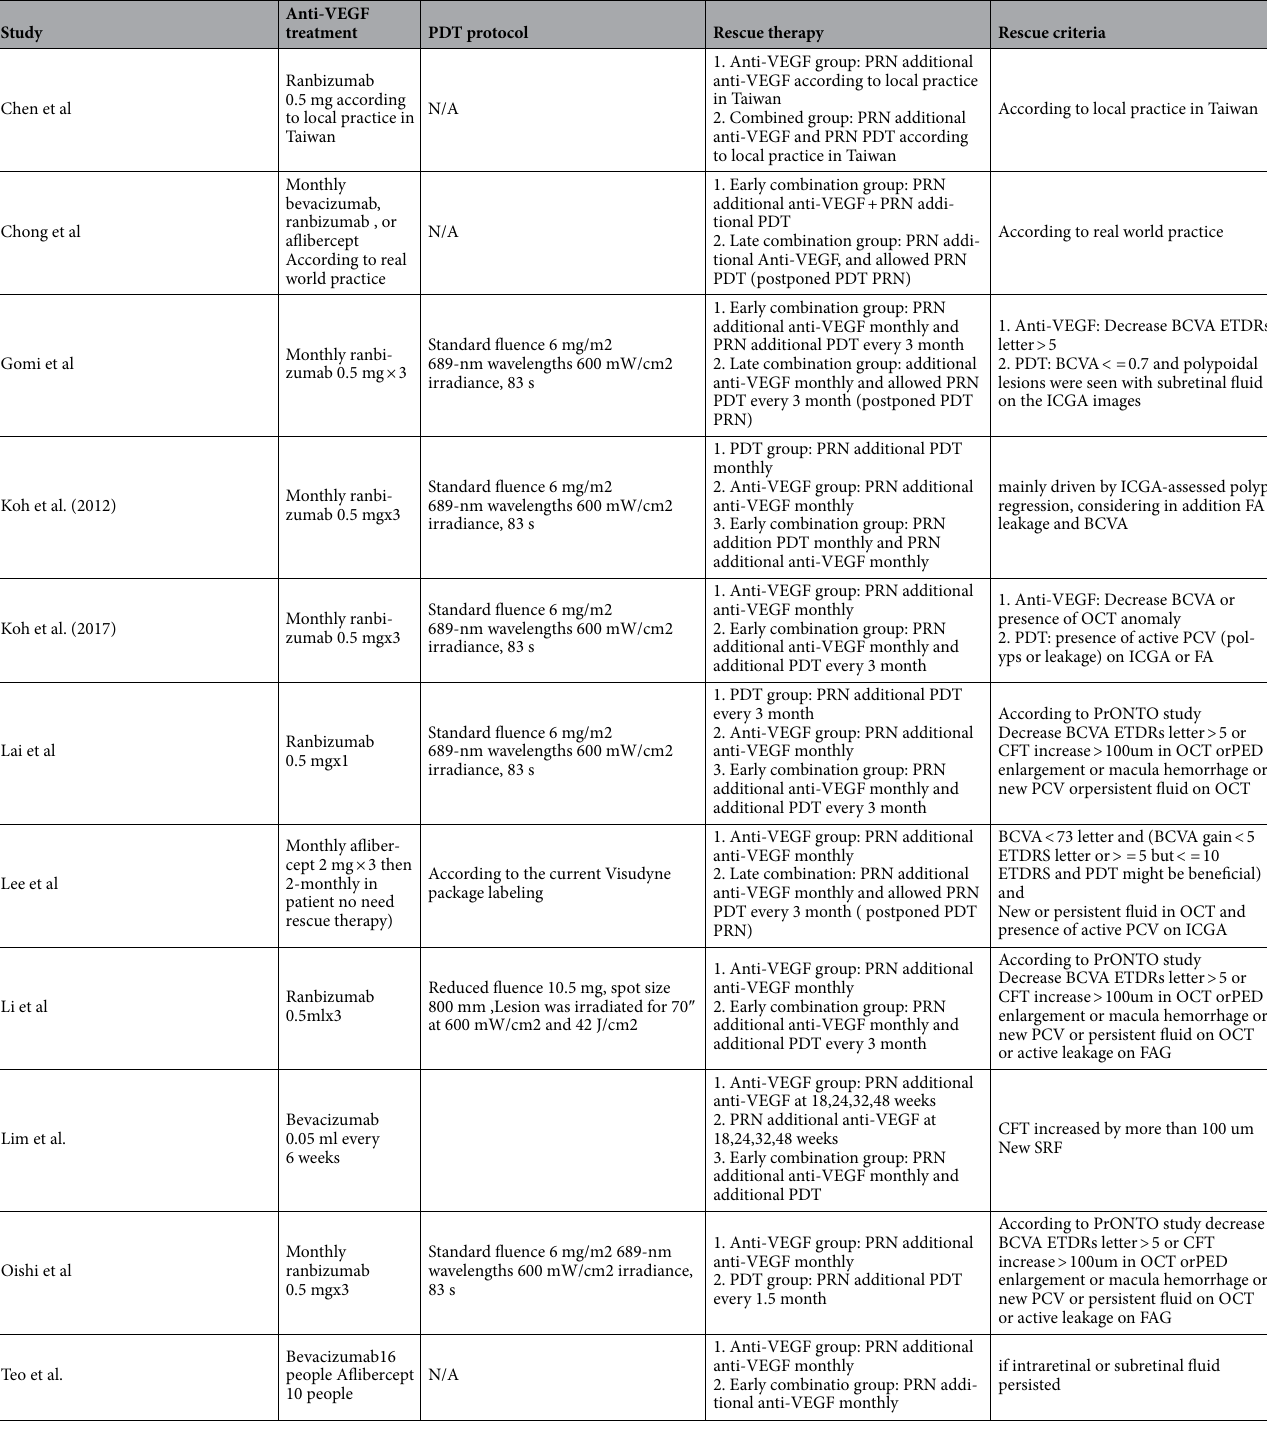
Table 2. Treatment